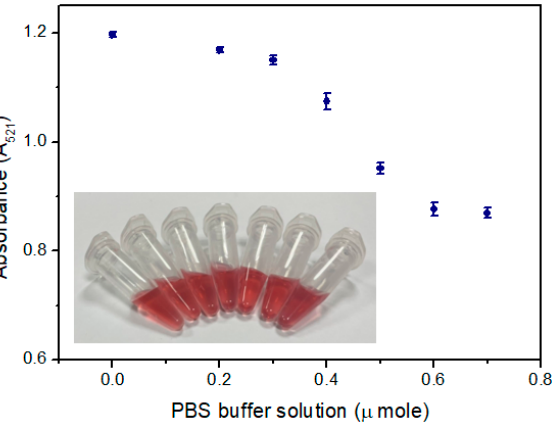
Figure 6. Absorbance at 521 nm of the blank test (without the existence of analyte) with di ff erent volumes of PBS bu ff er solution.